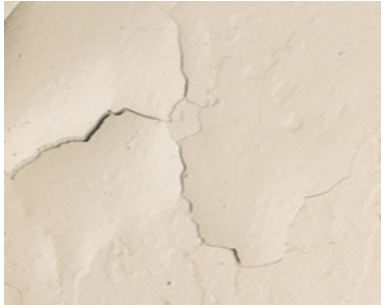
Figure 6. Cracking, bubbling and loss of paint adhesion to the substrate caused by high levels of moisture [1].